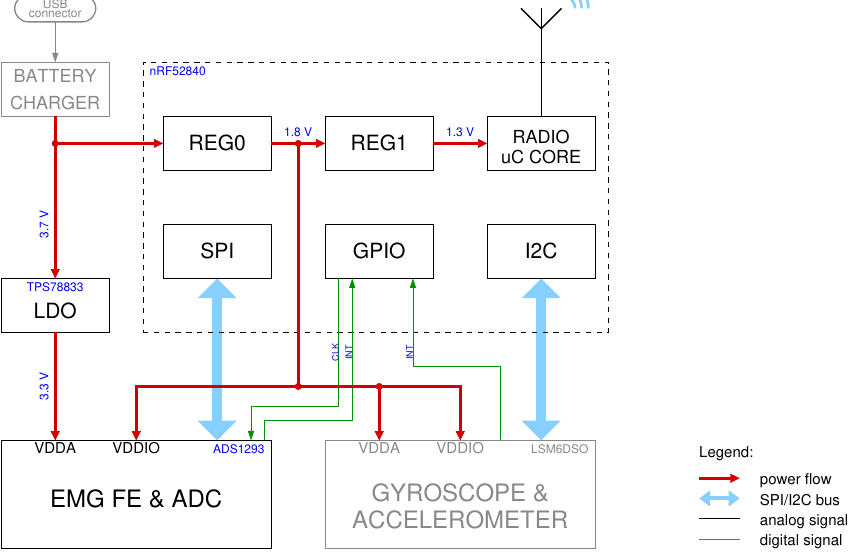
Figure 2. Simplified block diagram of the wireless EMG sensor [10] used for the